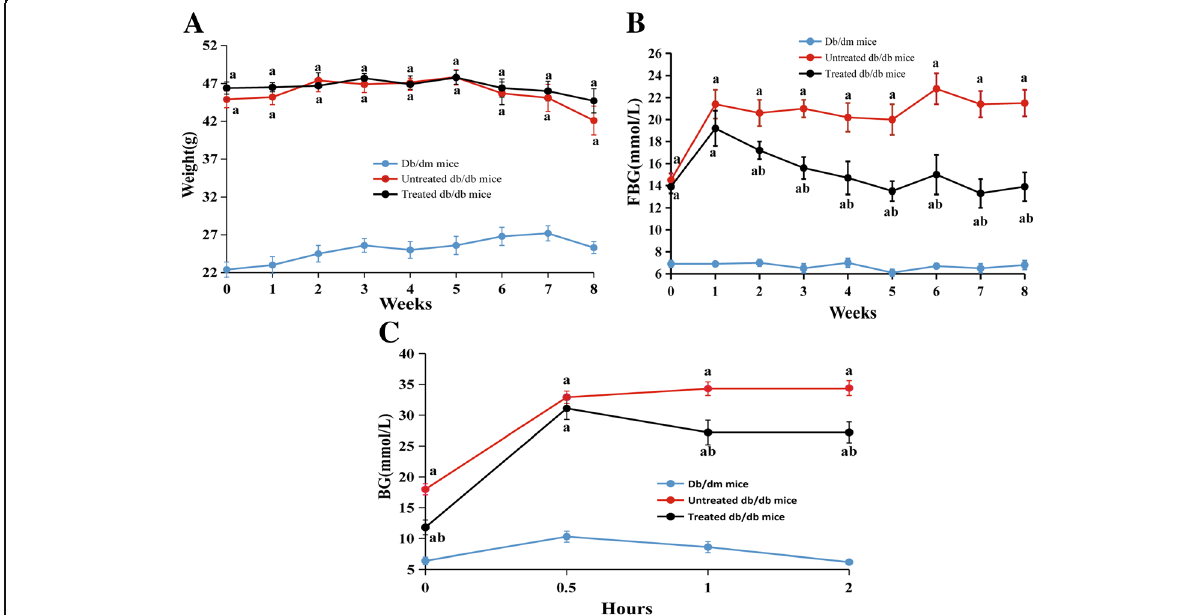
Fig. 2 Effects of Esculeoside A on body weight, FBG, and glucose tolerance in db/db mice. A Body weights, B FBG, and C glucose tolerance. The results are expressed as mean ± SEM ( n = 8 per group). Values having different superscripts are significantly different, P < 0.05, one-way ANOVA test. a. Statistical difference compared to the db/dm mice, b. Statistical difference compared to the untreated db/db mice